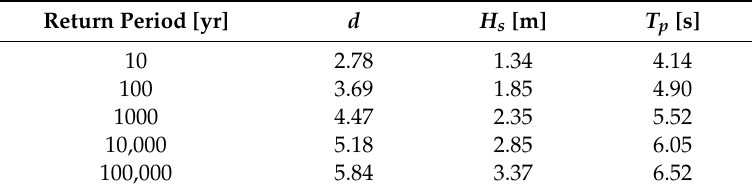
Table 1. Return periods of inundation depth ( d ), significant wave height ( H s ) and wave peak period ( T p ) at the edge of the Dollard marshes, as calculated with